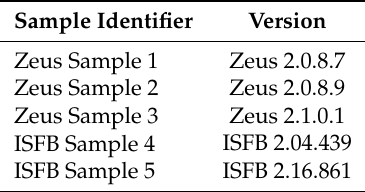
Table 2. Malware Sample